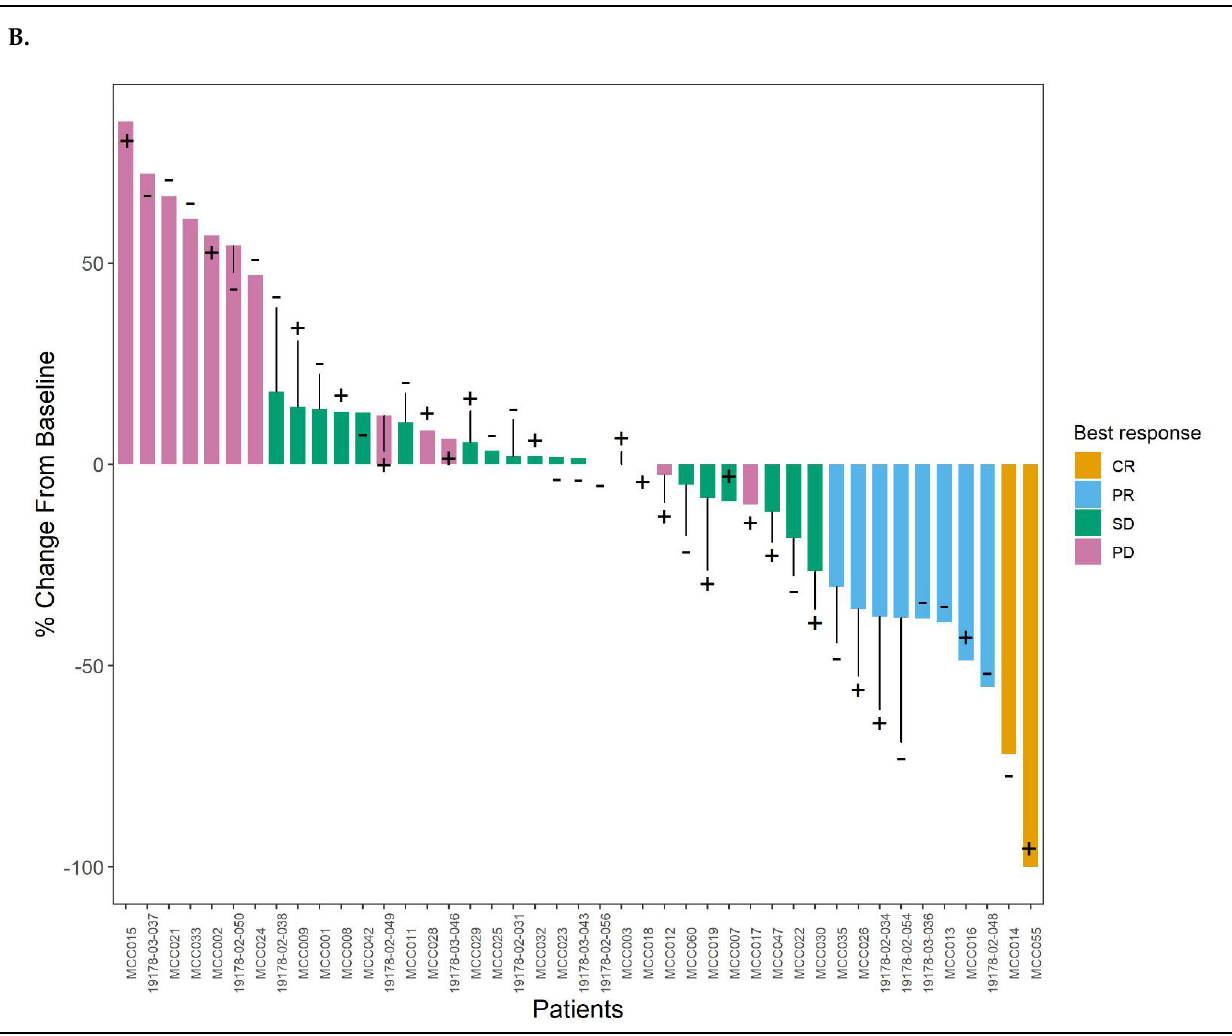
Figure 1. ( A ) Spider plot of best response. ( B ) Waterfall plot of best response. “+” indicates prior exposure to anti-PD-1 checkpoint inhibitors (CPI). “-” indicates no prior exposure to anti-PD-1 CPI.